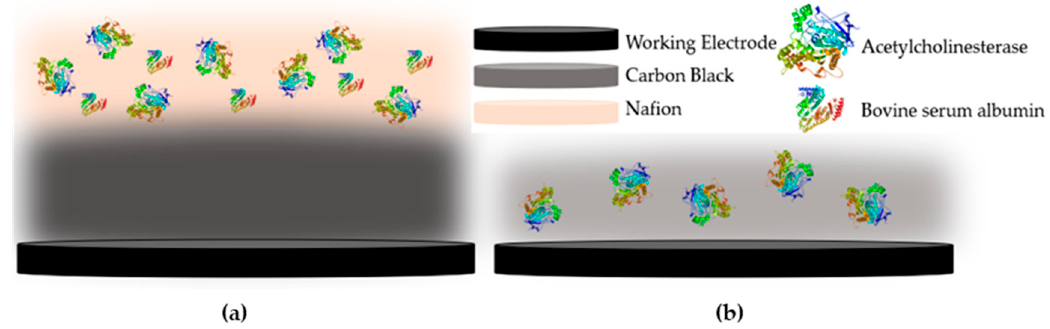
Figure 2. Graphical representation of the fabricated enzyme-based biosensor using ( a ) the multistep and ( b ) the one-step approaches.